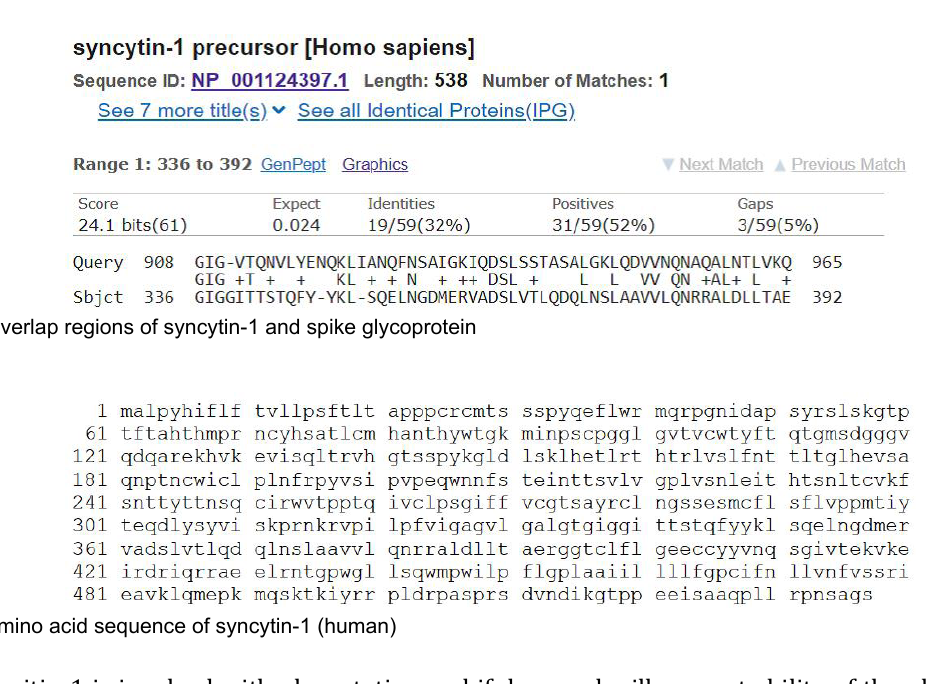
3) Syncitin-1 is involved with placentation and if damaged will prevent ability of the placenta to form or